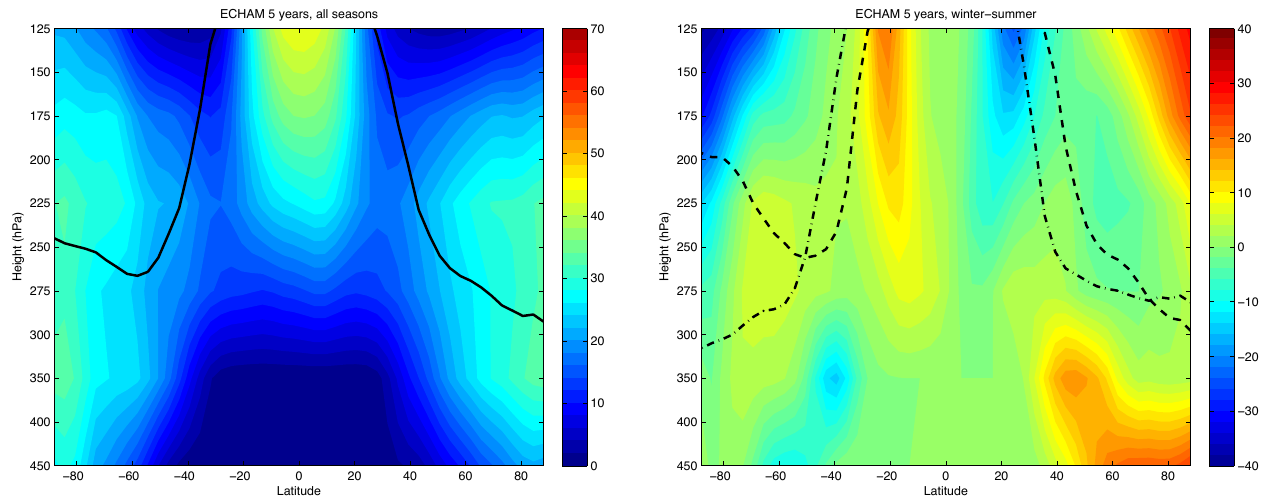
Fig. 21. Zonal means of ice supersaturation occurrence frequencies (%) from ECHAM (5yr of simulation) (left) along with boreal winter minus boreal summer differences (right). Plain line: zonal-mean tropopause (all seasons). Dashed line: zonal mean summer tropopause. Pointed dashed line: zonal mean winter